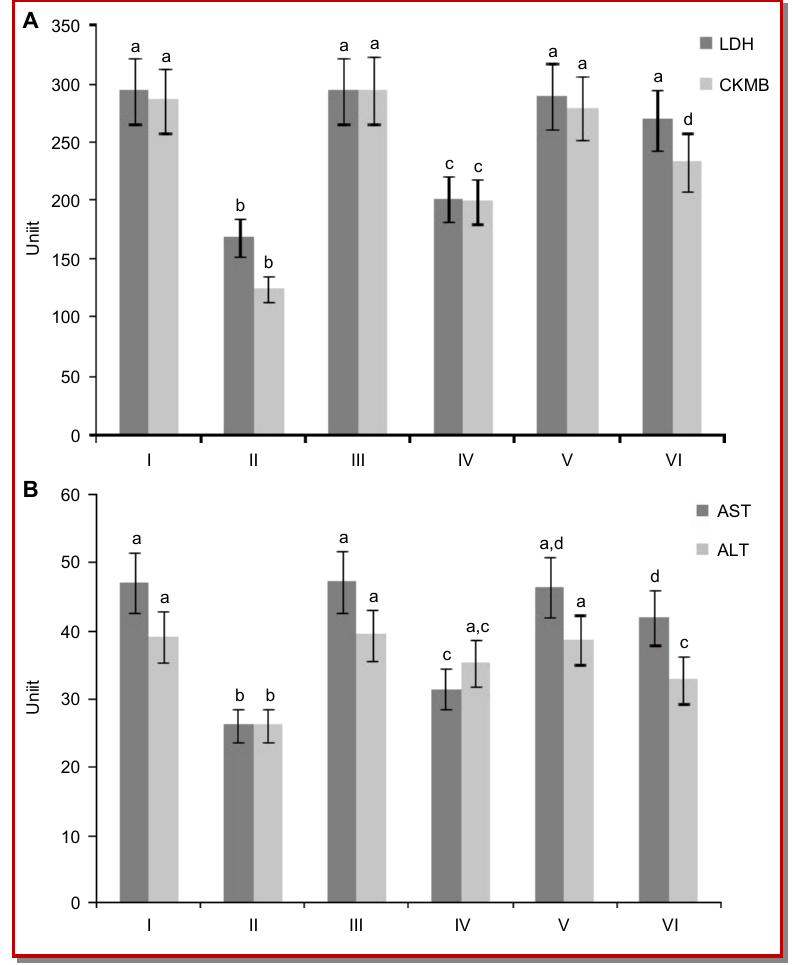
Figure 1: Activity of marker enzymes in heart. A) LDH and CK-MB; B) AST and ALT in heart tissue. Group I Normal, group II Isoproterenol, group III Coconut sprout (200 mg), group IV Coconut sprout (50 mg) + isoproterenol, group V Coconut sprout (100 mg) + isoproterenol, group VI Coconut sprout (200 mg) + isoproterenol. LDH expressed in µM of NAD + liberated/min/mg protein, CK- MB in µM of phosphorus liberated/min/mg protein, AST in µM of oxaloacetate liberated/min/mg protein and ALT in µM of pyruvate liberated/ min/mg protein. Values expressed as mean ± SD for six rats in each group. Values not sharing a common superscript (a, b, c, d) differ significantly at p<0.05